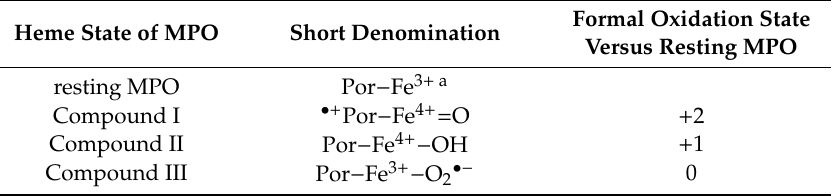
Table 1. Important heme states of myeloperoxidase.